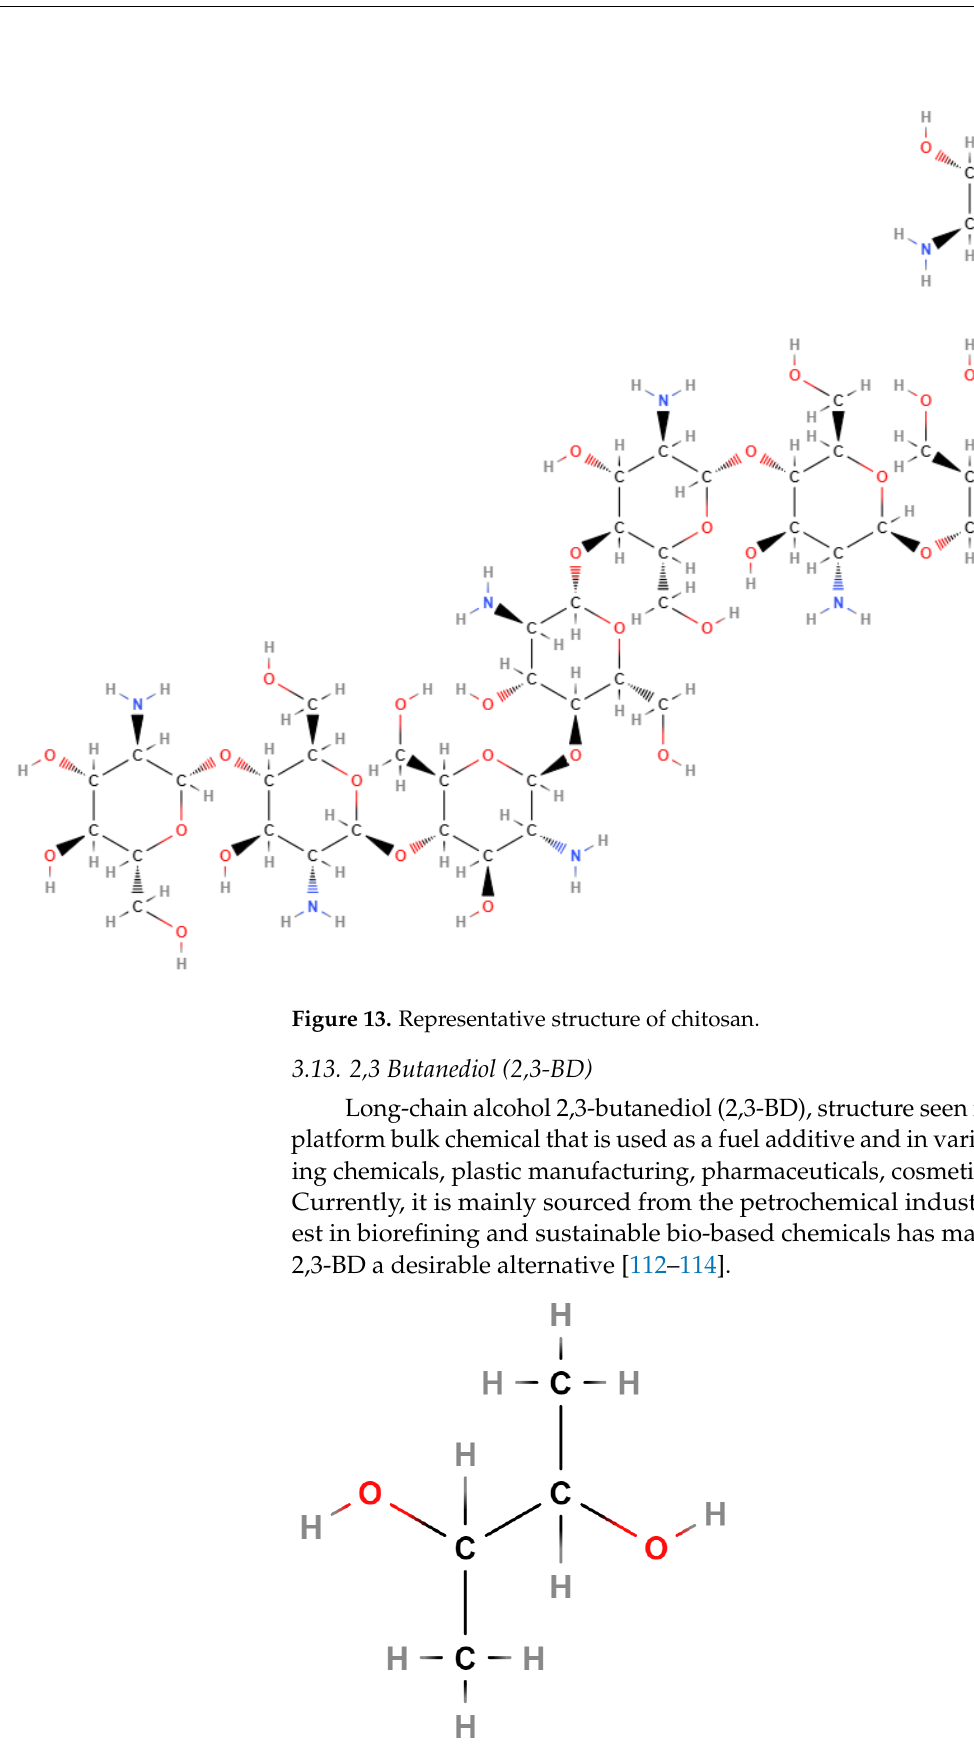
Figure 14. Structure of 2,3-BD (C 4 H 10 O 2 )